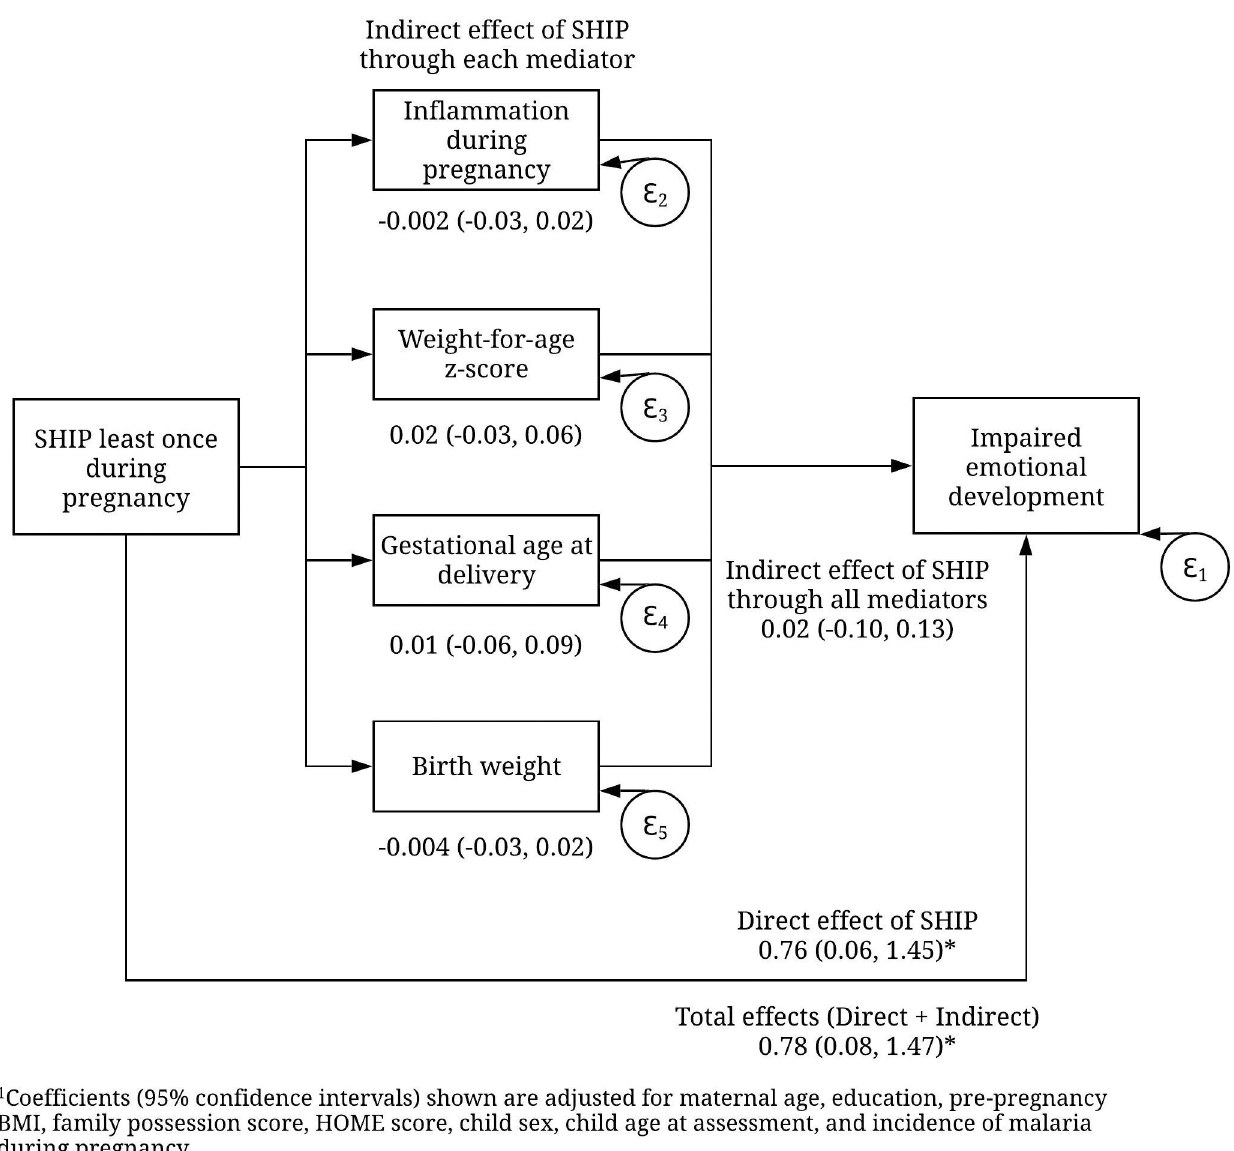
Fig 2. Mediation analysis between SHIP at least once during pregnancy and impaired emotional development in children at six years 1 . mediator: inflammation during pregnancy -0.002 (95% CI -0.03, 0.02), child weight-for-age-z- score 0.02 (95% CI -0.03, 0.06), gestational age at delivery 0.01 (95% CI -0.06, 0.09), or birth weight -0.004 (95% CI -0.03, 0.02). The total effect of SHIP on impaired emotional develop- ment was statistically significant 0.78 (95% CI 0.08, 1.47), however less than 3% of the total effects could be explained by the indirect effects of potential mediators tested. After multiple imputation of missing outcomes, co-variables, and children lost to follow-up between birth and six years of age, helminth infections at 1 st ANV, 2 nd ANV/delivery, and at least once during pregnancy were significantly associated to higher SDQ internalizing scores after adjusting for confounding factors (Table 5). Hookworm infections at the 2nd ANV/deliv- ery and at least once during pregnancy were associated with higher internalizing scores in